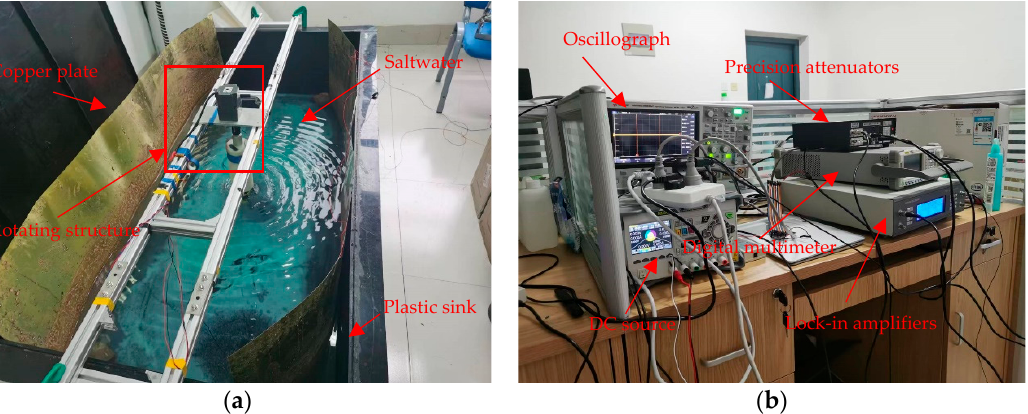
Figure 6. Laboratory simulation of ocean current environment construction diagram: ( a ) XCP simulated ocean current electric field and probe fixed rotating device. ( b ) XCP signal source and signal monitoring equipments. Table 1. DC electric field test